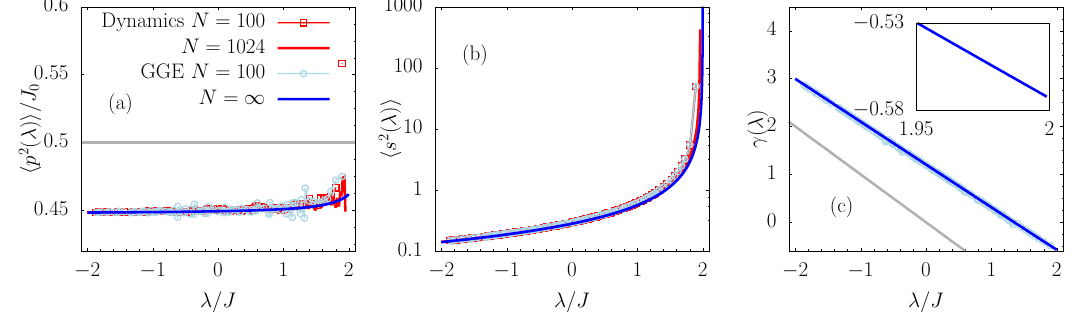
Figure 13: Comparison of the dynamic and GGE results in phase III, with energy injection. The quench parameters are T 〈 s 2 ( λ ) 〉 and (c) GGE Lagrange multipliers γ ( λ ) . Note the divergence of 〈 s 2 ( λ ) 〉 the edge of the spectrum and the finite value that 〈 p 2 reason for the deviating dynamic point in (a) is discussed in the text. The grey curves represent the initial values. The inset in (c) highlights the behaviour of γ ( λ ) close to the edge.